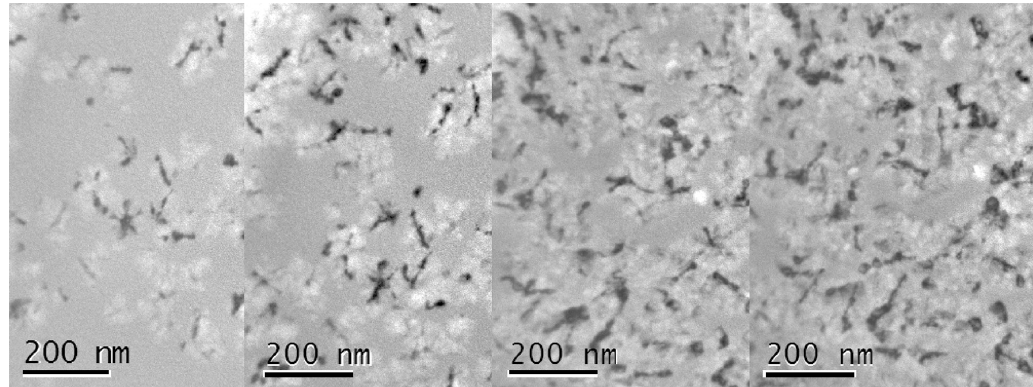
Figure 6. Structure evolution by TEM micrographs of rapidly quenched (Fe 673 K at the time: t